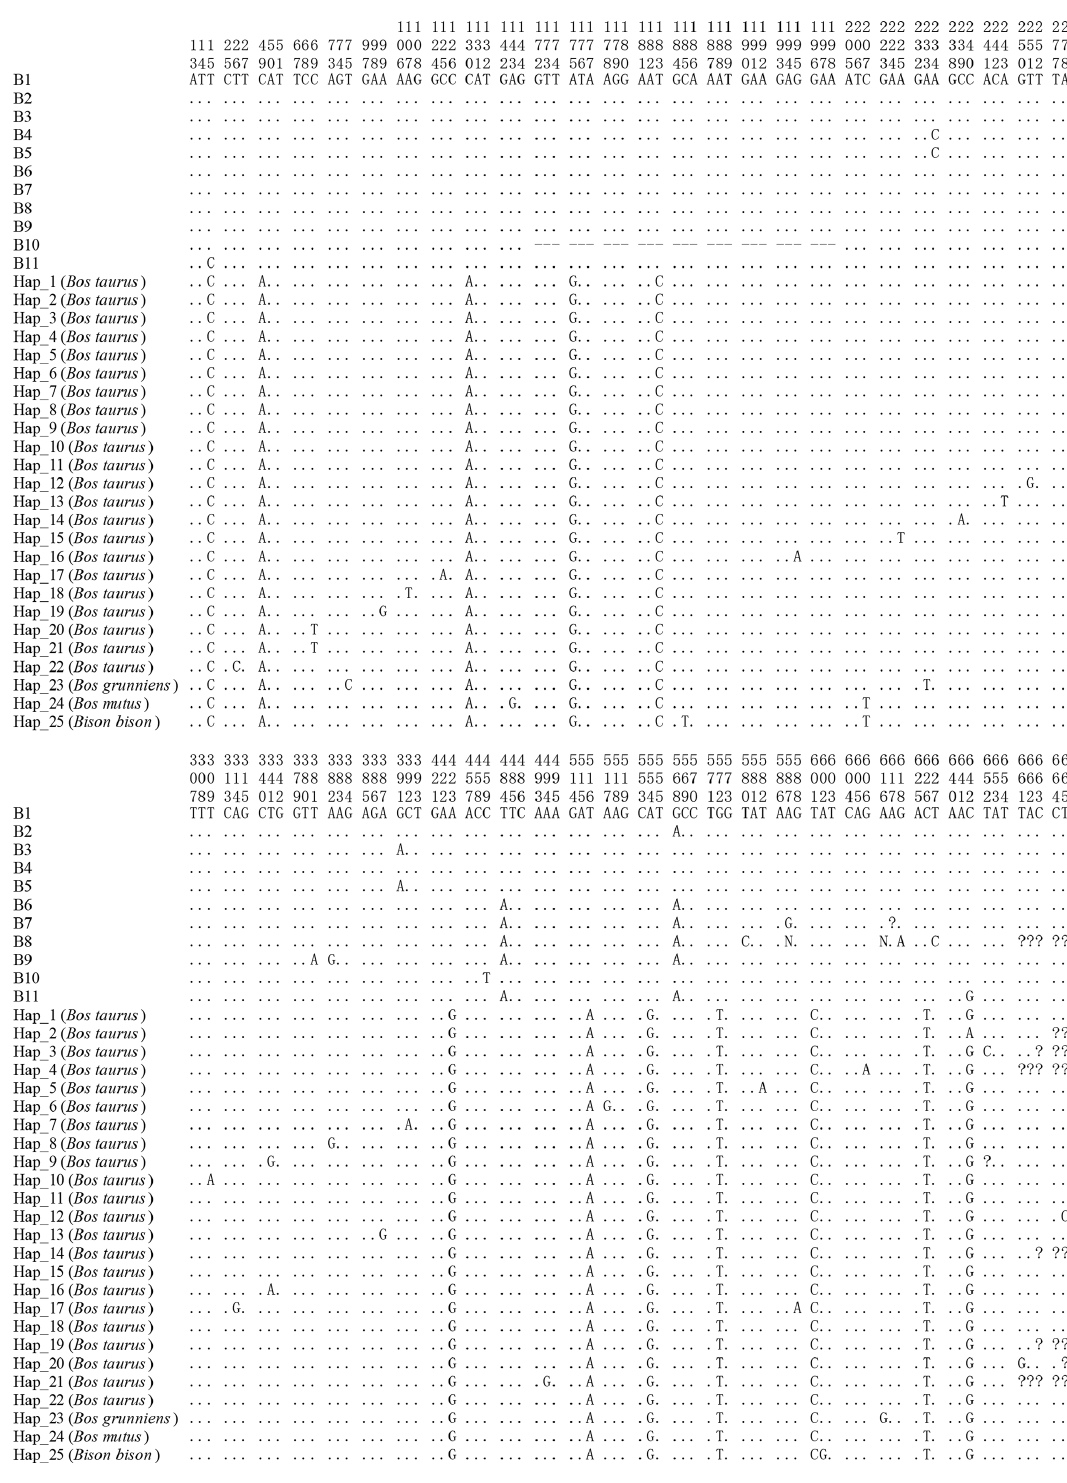
Figure 3. Sequence difference sites of the haplotypes between buffalo and bovine. The corresponding accession numbers of 25 haplotype sequences (Hap1 to Hap25) of the Bos genus are XM_024993017, DR712148, DR711516, DT854174, DR711908, DT849277, DR712290, DR711611, DR711989, EH123804, DR711761, DR71135, M16644, DR711495, DR711941, DR711568, BC114773, DR711392, DR711419, BG690139, BG691827, DR711347, MH378279, XM_014480230 and XM_010852145, respectively. Numbers represent the position in the CDS. Dots (.) represent the identity with the haplotype B1. Nucleotide substitutions are denoted by different letters. Horizon- tal lines (–) represent the deletion in the sequences. Missing information is denoted by the question marks